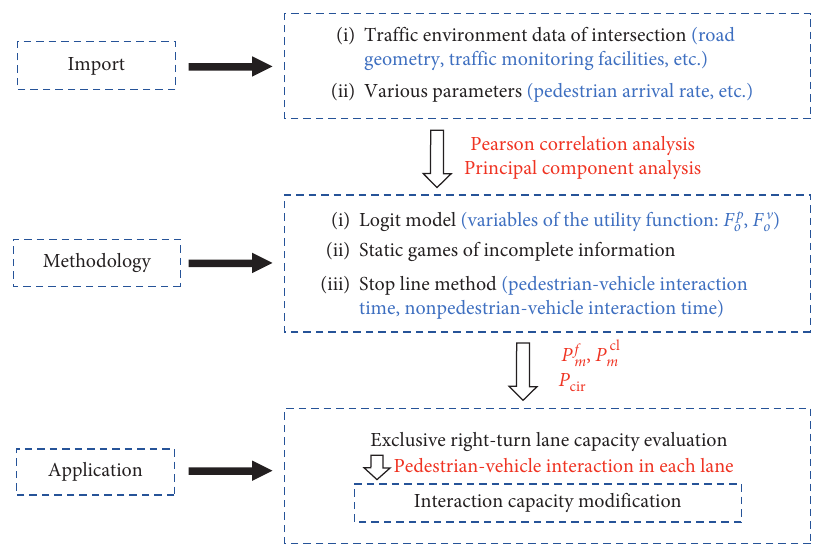
Figure 1: Layout of construction for the PV-RTC